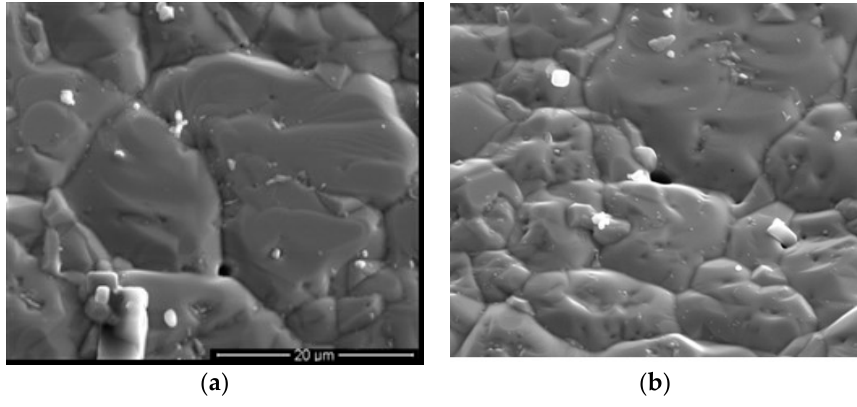
Figure 11. ( a ) Top-down and ( b ) 20° tilted SEM images of SS 316L sample surface, 2500 h testing (5000×).